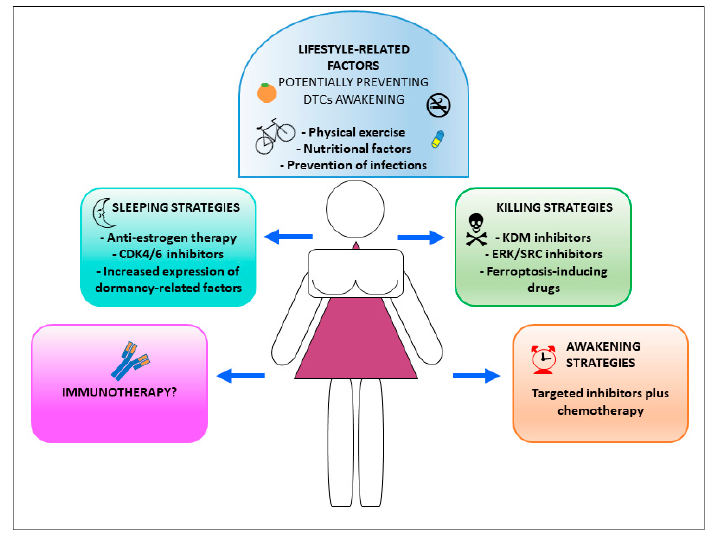
Figure 3. Therapeutic strategies and factors related to DTCs dormancy in breast cancer (BC) patients. Distinct therapeutic strategies and lifestyle habits cooperate to prevent tumor relapse in BC patients.